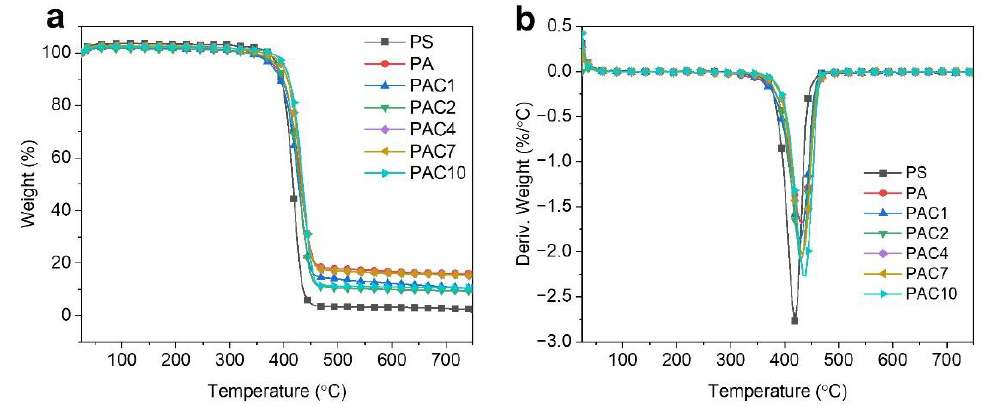
Figure 4. ( a ) TG and ( b ) derivative TG curves of PS and its composites. Table 1. The related thermal data of PS and its composites under nitrogen conditions. Sample No.